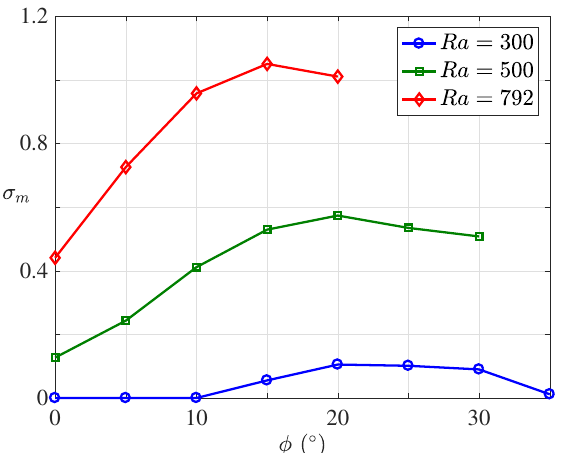
Figure 8. Variation of the maximum growth rate, σ m , with φ at moderate Ra , L s = 2 and β = 0. At Ra = 300, the steady state is marginally stable for φ < 10 ◦ and becomes weakly unstable at φ = 10 ◦ . The same branch of steady states is not obtained at large φ for Ra = 500 and 792 using the present numerical scheme.